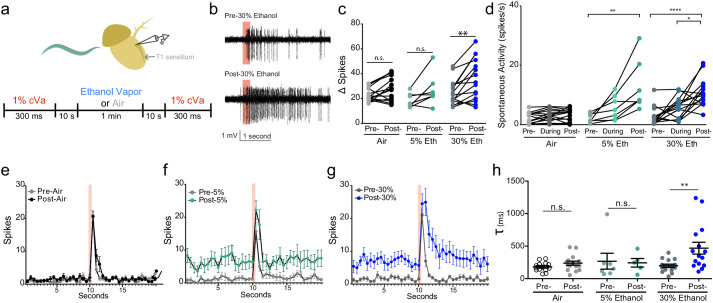
Alcohol odor potentiates the response to cVa.(a) Experimental timeline and diagram of recording site on fly antenna. (b) Traces of cVa-sensing T1 neurons. The red bar denotes 300 ms cVa exposure. (c) Δ Spikes calculated as cVa-induced activity (1 s during and after cVa) – spontaneous activity (paired two-tailed t-test, p=0.002, n = 7,15,15). (d) Spontaneous activity before, during, and after ethanol exposure. Spontaneous activity calculated as the total number of spikes 10 s prior to cVa delivery/10 s (Pre- vs. Post-5% p=0.002, Pre- vs. Post-30% p<0.0001, During vs. Post-30% p=0.0152, Kruskal-Wallis test with Dunn’s correction). (e), (f), (g) Averaged spikes over time for air, 5% ethanol, and 30% ethanol, respectively. Red bar denotes 300 ms cVa exposure (h) Time constant (τ) of decay of the cVa-induced spikes (Mann-Whitney test, p=0.0043). p>0.05, n.s. (not significant); p<0.05 *; p<0.01 **; p<0.0001 ****. Error bars denote SEM.